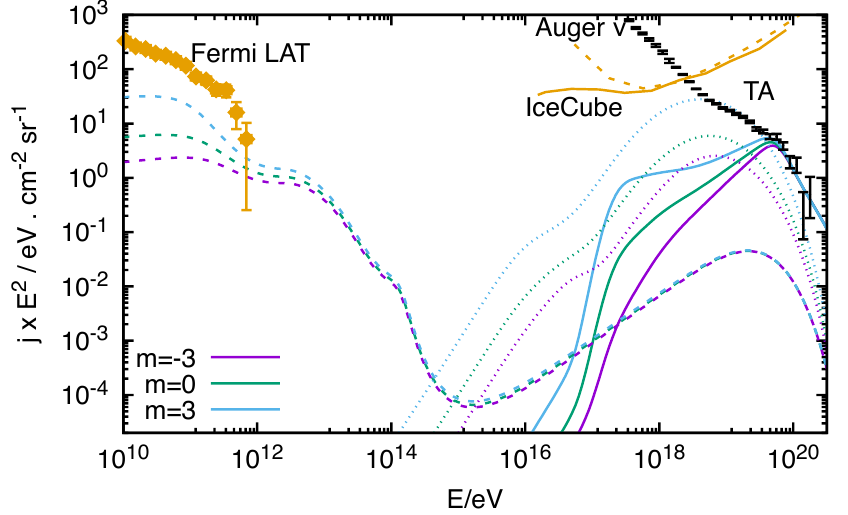
Figure 4. Highest primary proton spectrum allowed by the criterion in Equation (2) (solid lines), and corresponding photon (dashed lines) and all flavor neutrino (doted lines) spectra produced in the source model of Figure 1, but for different values of the source evolution parameter m ( m = and 3 in magenta, green, and sky blue, respectively). The lower radio background model of [44] is used, multiplied by F rad = 0.1 (as in Figure 1). The isotropic diffuse photon flux measured by Fermi LAT [38] and the upper bounds on all flavor neutrino diffuse flux by IceCube and Auger [39], shown in ochre, do not constrain the primary proton flux. The figure shows that the predicted GZK photon spectrum is the same for all three evolution